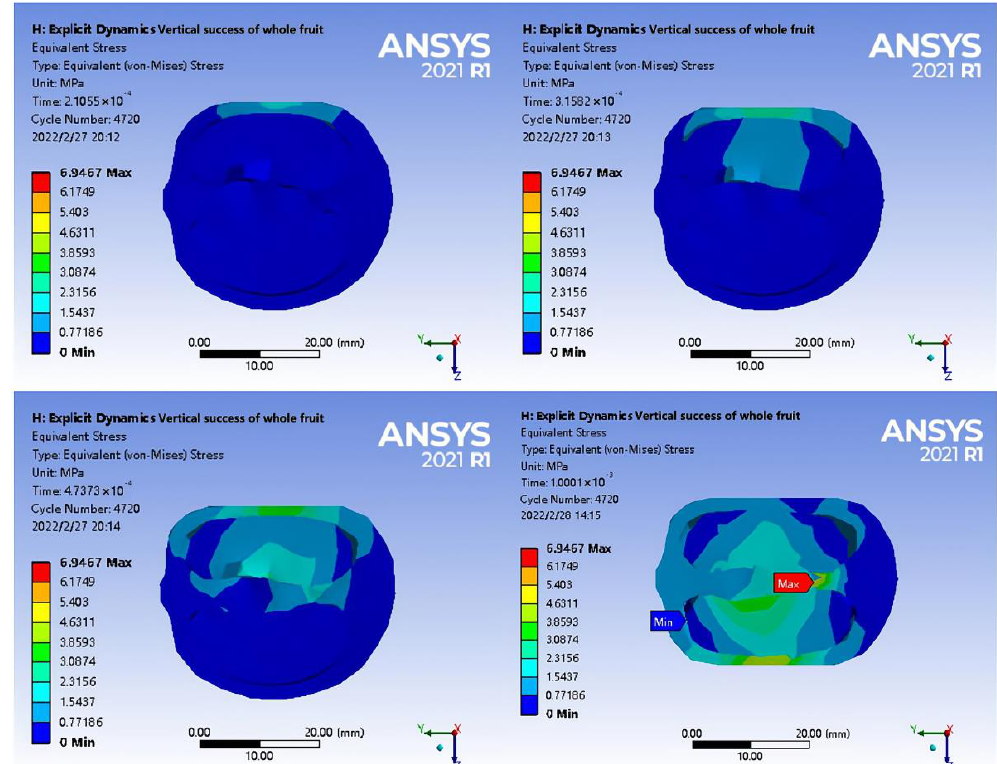
Figure 14. Radial loading stress change diagram of half-section fruit. Table 3. Extrusion simulation results of fresh Camellia oleifera fruit.